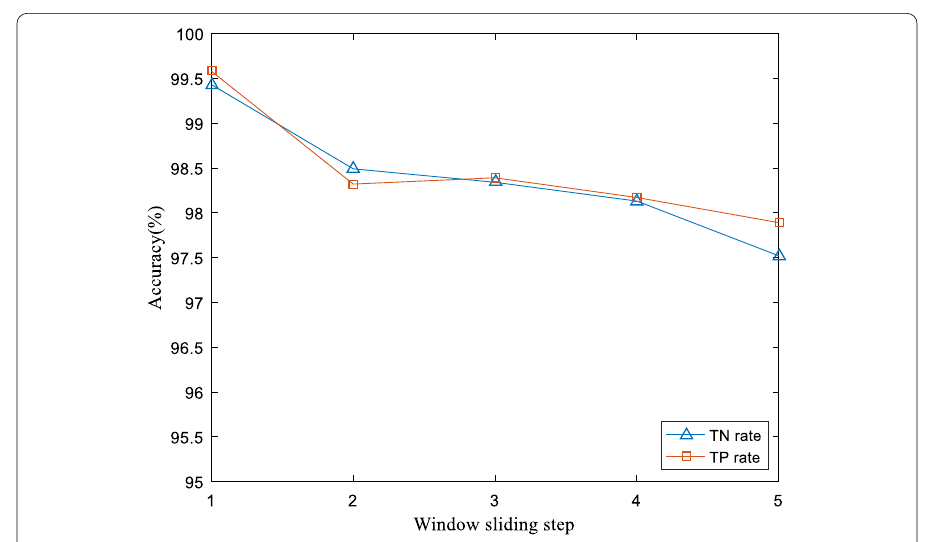
Fig. 14 Detection TN rate and TP rate with different window sliding steps